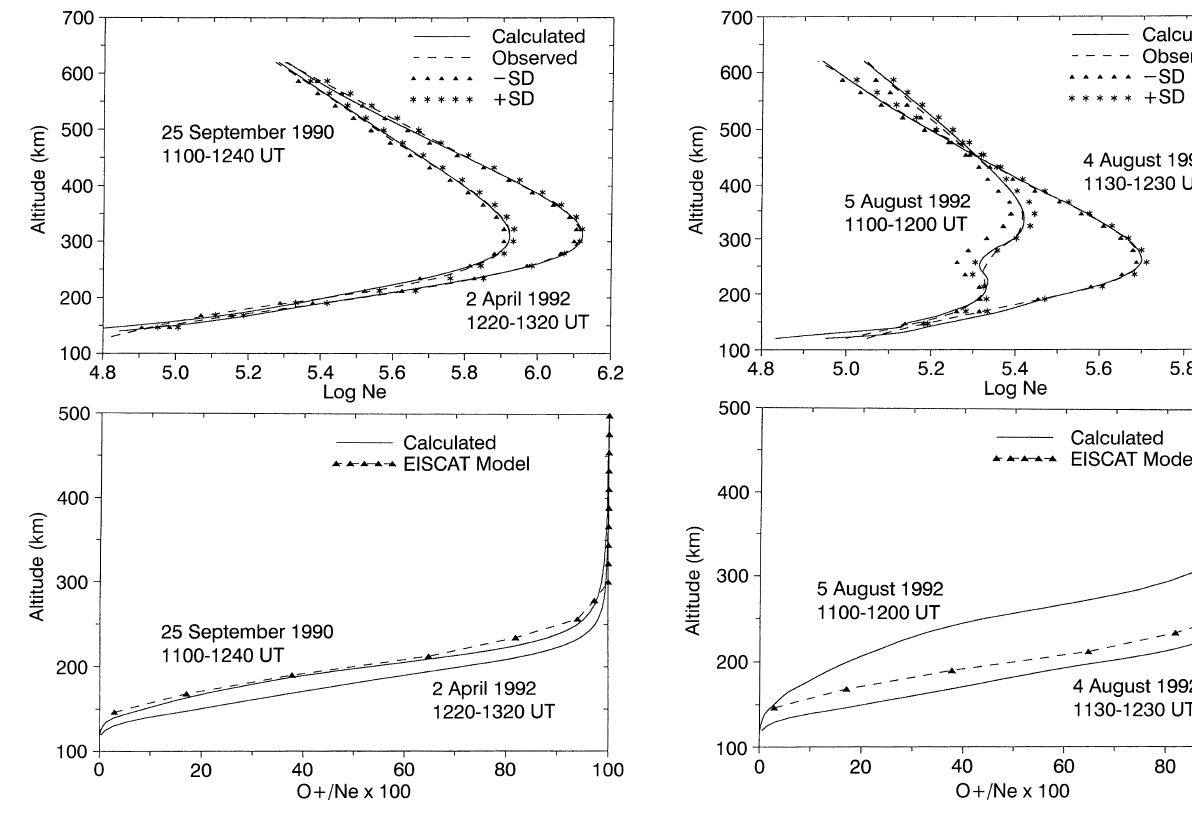
Fig. 3. Observed (together with a band of standard deviations) and calculated N e (cid:133) h (cid:134) profiles for two geomagnetically quiet equinoctial days 25 September 1990 and 2 April 1992 ( top panel ). Calculated and EISCAT model [O (cid:135) ]/ N e height variations for two days ( bottom panel )